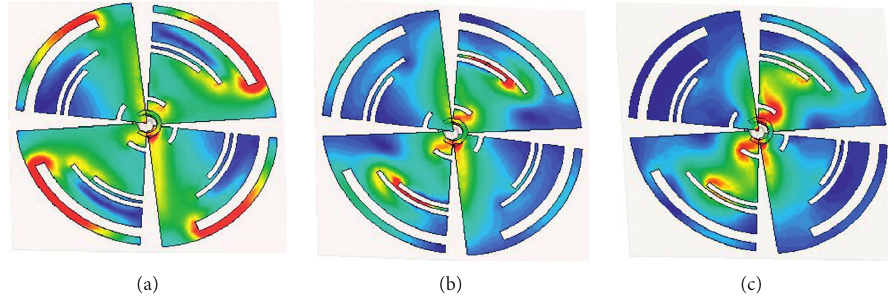
Figure 12: Current distribution of the antenna. (a) 875MHz. (b) 1730MHz. (c)